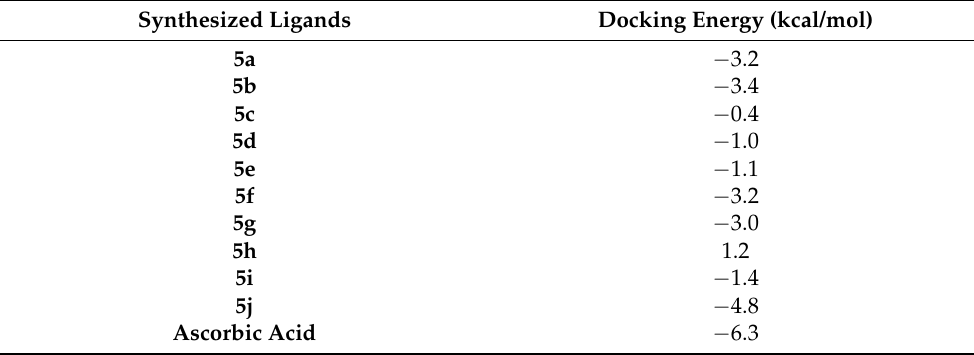
Table 4. Docking energy values of synthesized furan-oxadiazole ligands 5a–j in